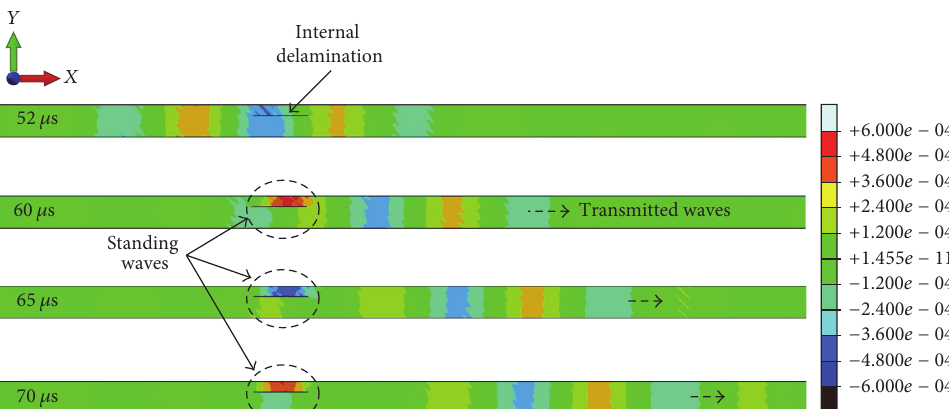
Figure 1: Description of 2D plane strain FE model.